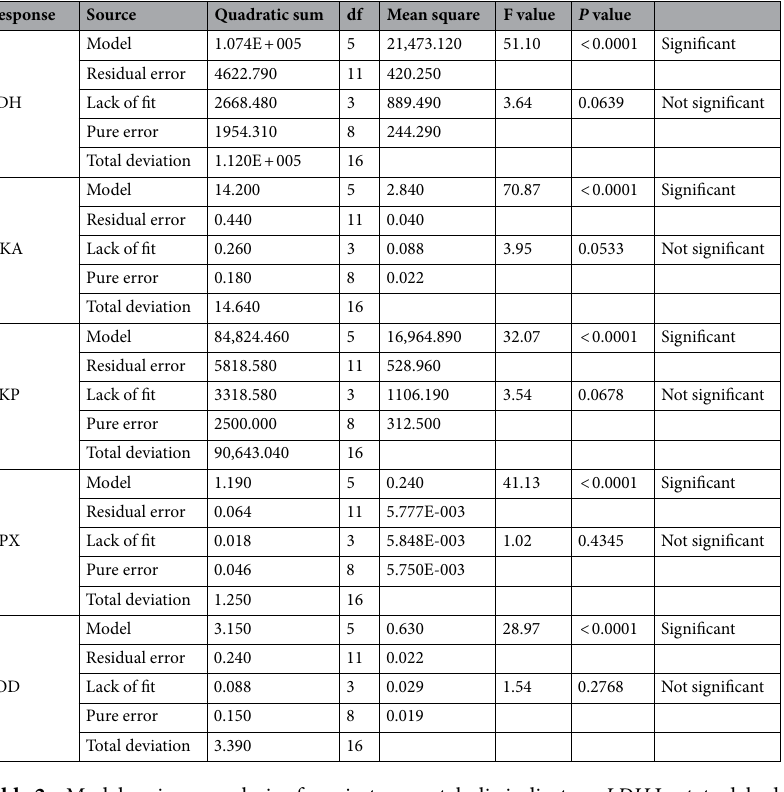
Table 2. Model variance analysis of respiratory metabolic indicators. LDH Lactate dehydrogenase activity in gills, NKA Na + -K + -ATPase activity in gills, AKP Alkaline phosphatase activity in gills, GPX Relative expression levels of GPX antioxidant genes in gills, SOD Relative expression levels of SOD antioxidant genes in